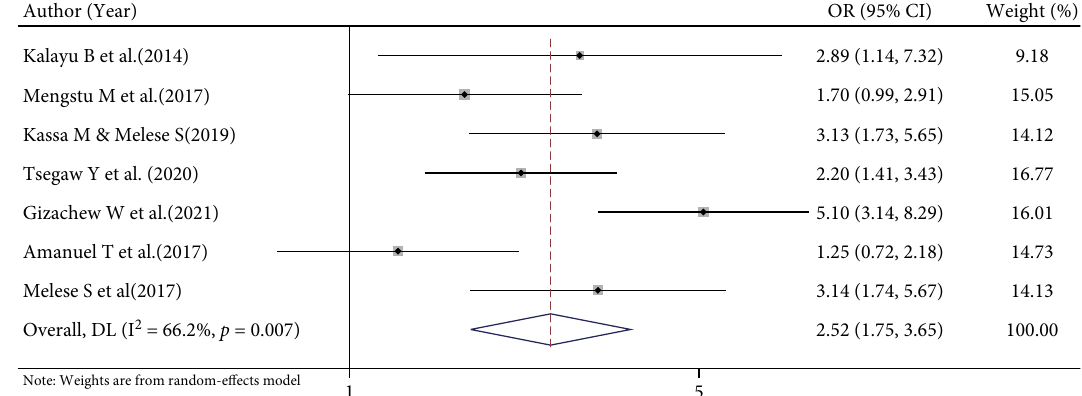
0.007)Melese Overall, DL (I 2 = 66.2%, p =